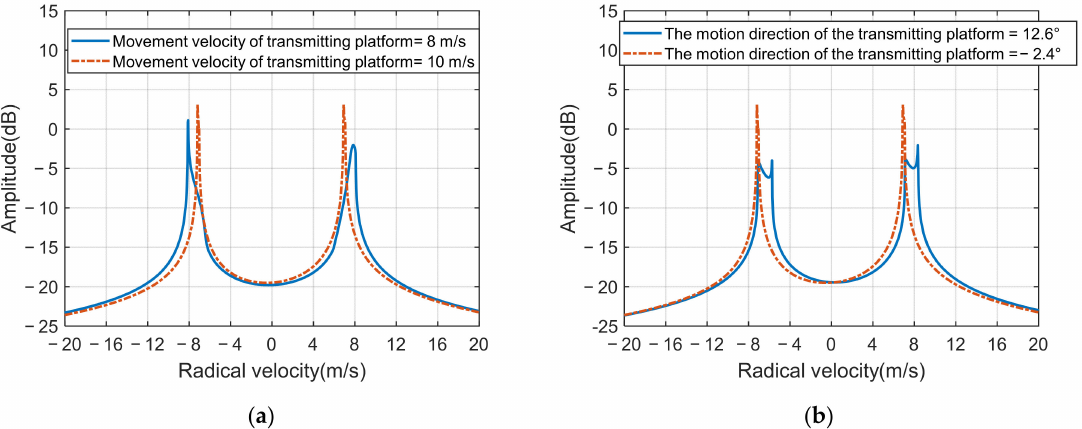
Figure 6. Simulated first-order Doppler spectra for which the transmitting and receiving platforms do not move along the baseline. ( a ) Different transmitting platform moving speeds. ( b ) Different transmitting platform moving directions.